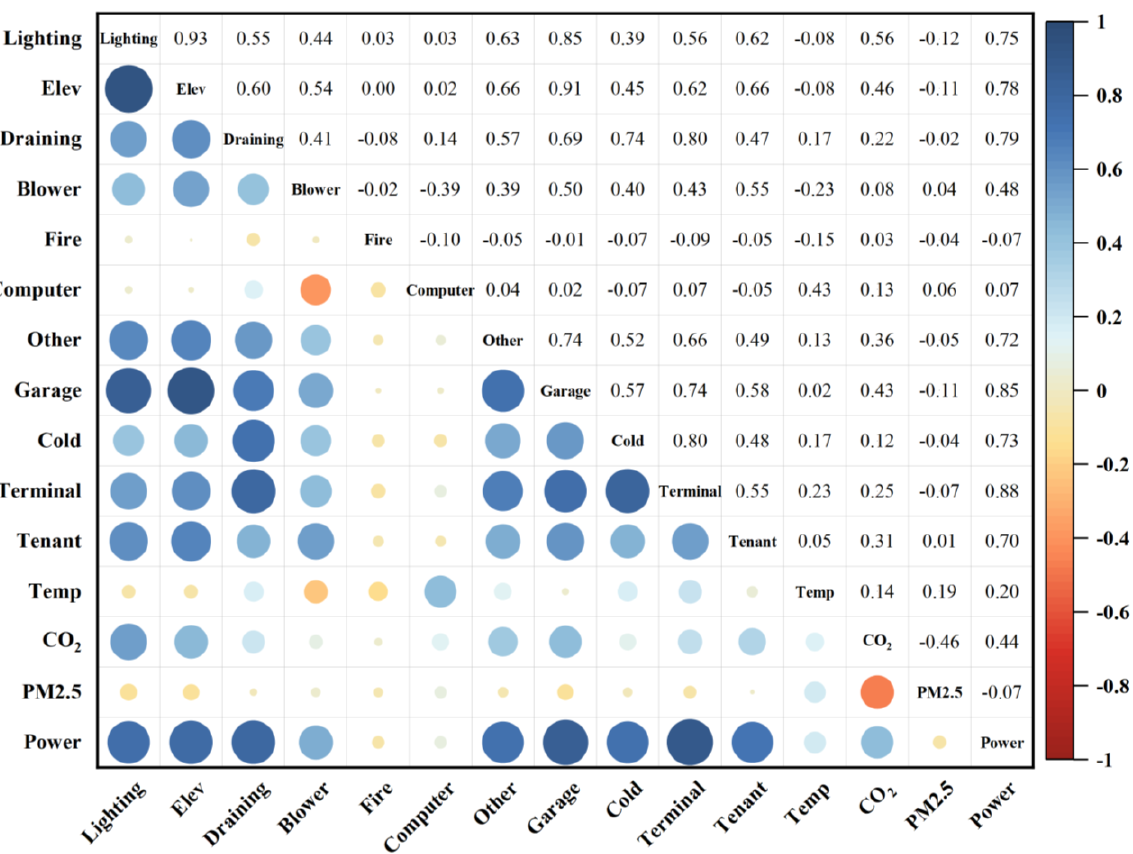
Figure 7. Pearson correlation coefficients of different variables in the green building.